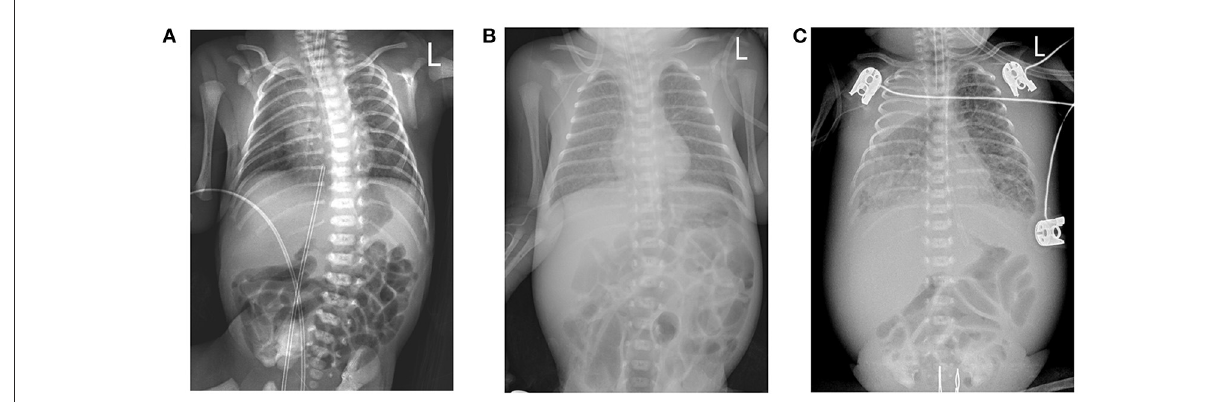
FIGURE1 (A) Chest X-ray image shows a bilateral thickening of lung markings, with patchy and blurred shadows in the lower lung fields. (B) Chest X-ray image depicts thickening and blurring of bilateral lung markings, with small patches of fuzzy shadows in the lung fields. (C) Chest X-ray image shows that the texture of both lungs was thickened, increased, and blurred. Large dense shadows of uniform density were observed in the right upper lung field, and small patchy blurred shadows were found in the remaining lung fields. There was a narrow band of increased density in the field of the right lower lung that contained a clear